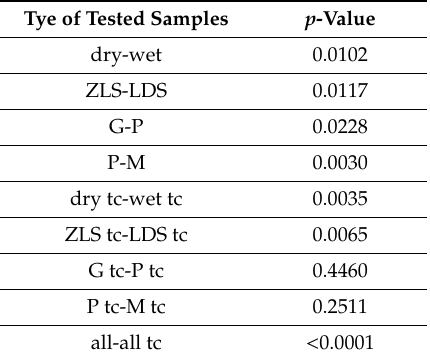
Table 2. p -values for the translucency variations of the tested samples.